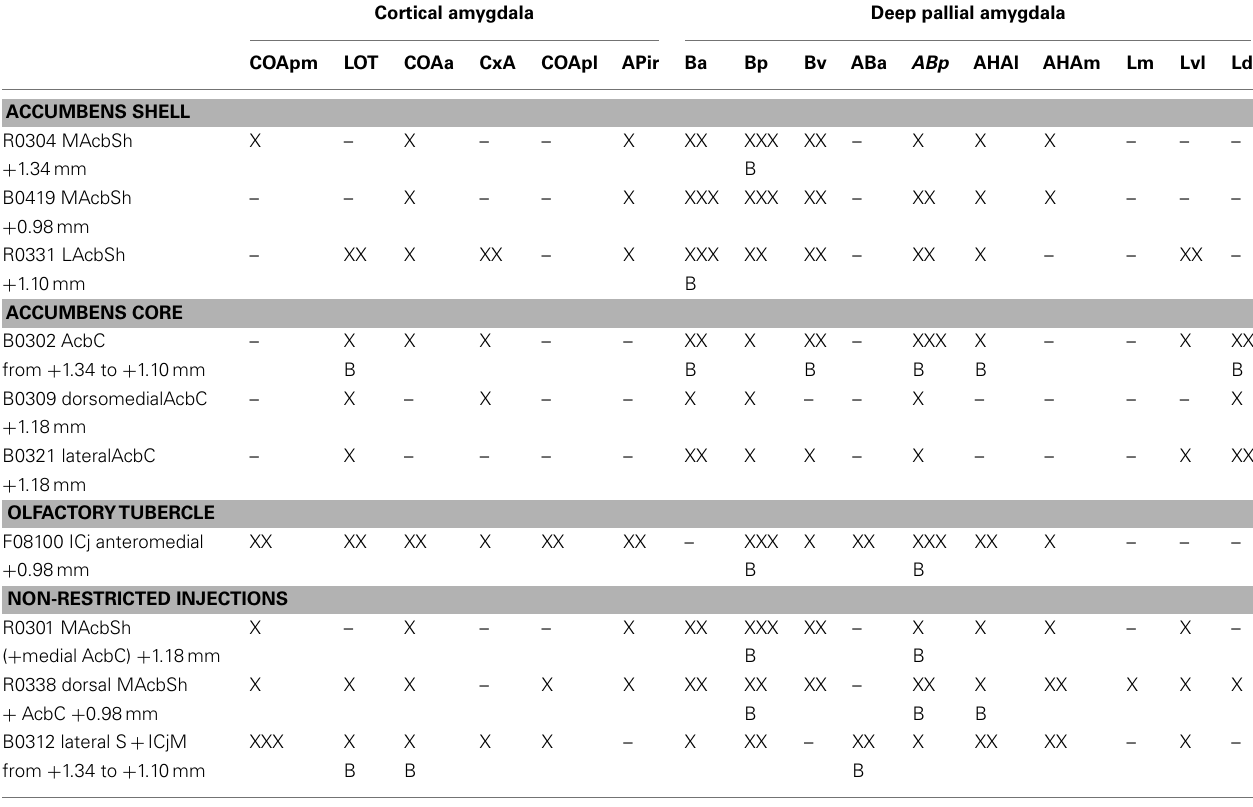
Table 1 | Retrogradely labeled neurons in the different areas of the pallial amygdala (columns) after injections in the ventral striatum (rows) graded semi-quantitatively according to the following scores: –, absent; X, scarce; XX, moderate; XXX, dense; B, contralateral